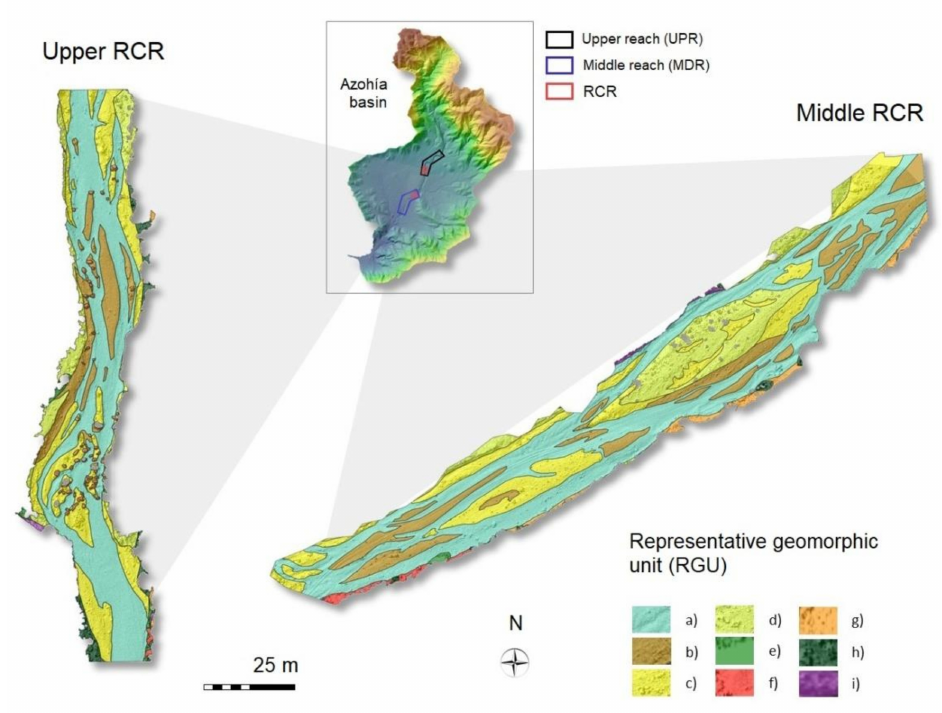
Figure 5. RGU extracted within the boundaries defining each peak flow in the Upper and Middle RCR: a. Active channel, secondary minor channel inter-bars or run; b. Low, active non-vegetated bar; c. Low, scarcely vegetated bar; d. High, active non-vegetated bar; e. High, scarcely vegetated bar; f. High, vegetated bar; g. Non-vegetated talus or steep bank; h. Non-vegetated steep bank with falling rock blocks; i. Scarcely vegetated talus or steep